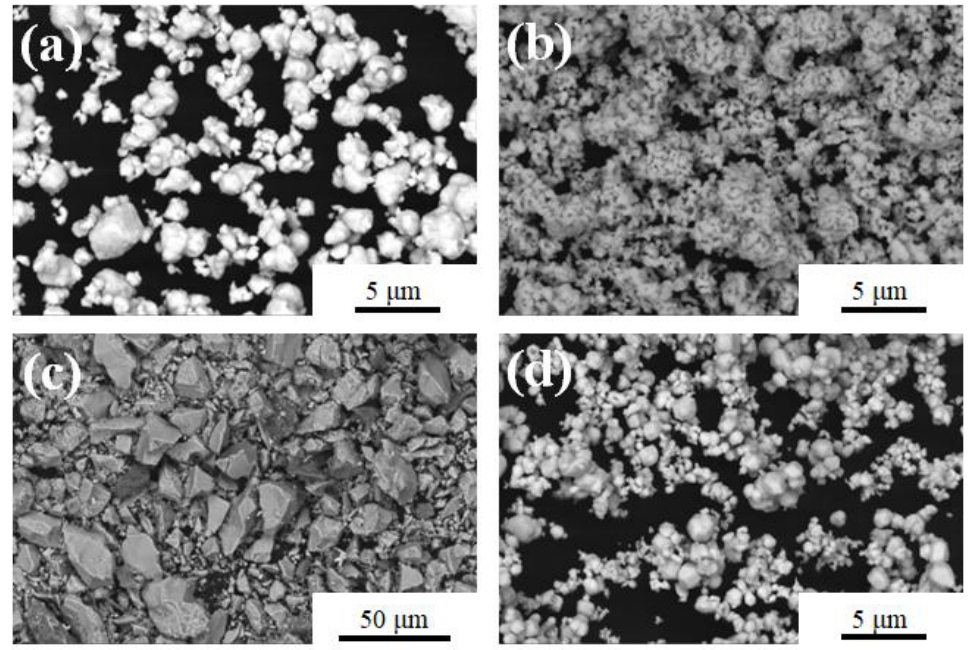
Figure 1. BSE-SEM of raw powders. ( a ) WC, ( b ) Co, ( c ) Fe, ( d ) W. Table 1. The nominal chemical compositions of WC-13(Co-Fe) composites (wt.%).